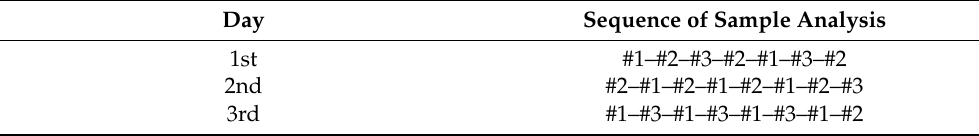
Table 2. Program of